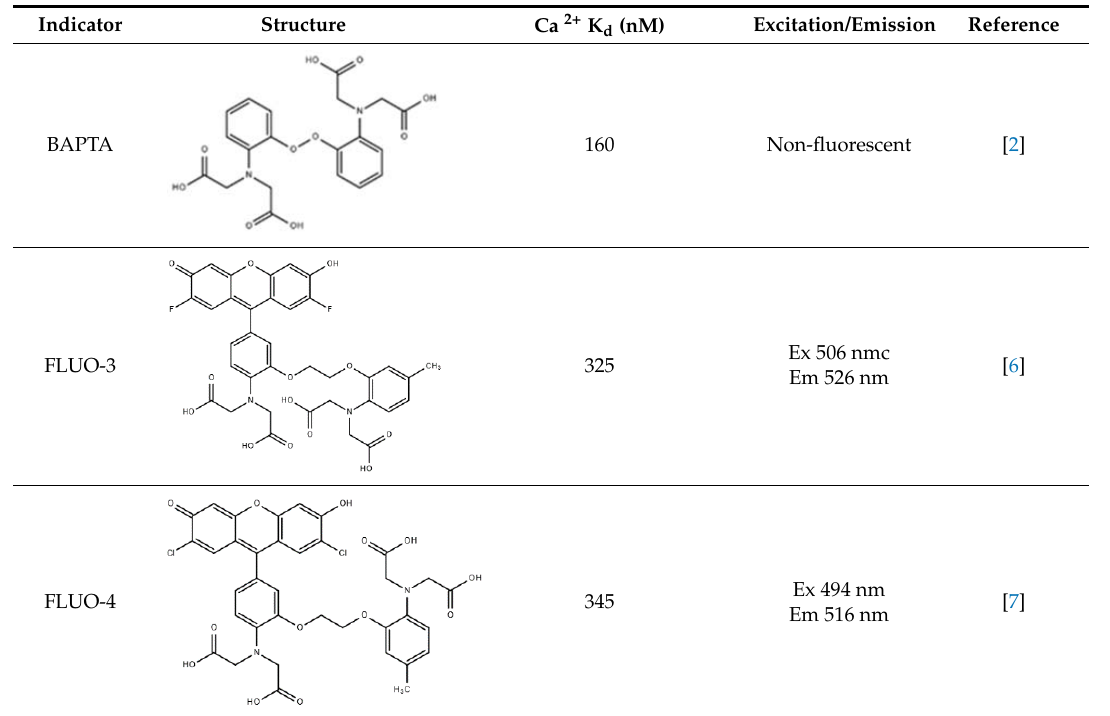
Table 1. A summary of structures, (in vitro) K d and excitation/emission wavelengths of commonly used chemical indicators to investigate cardiac calcium handling.